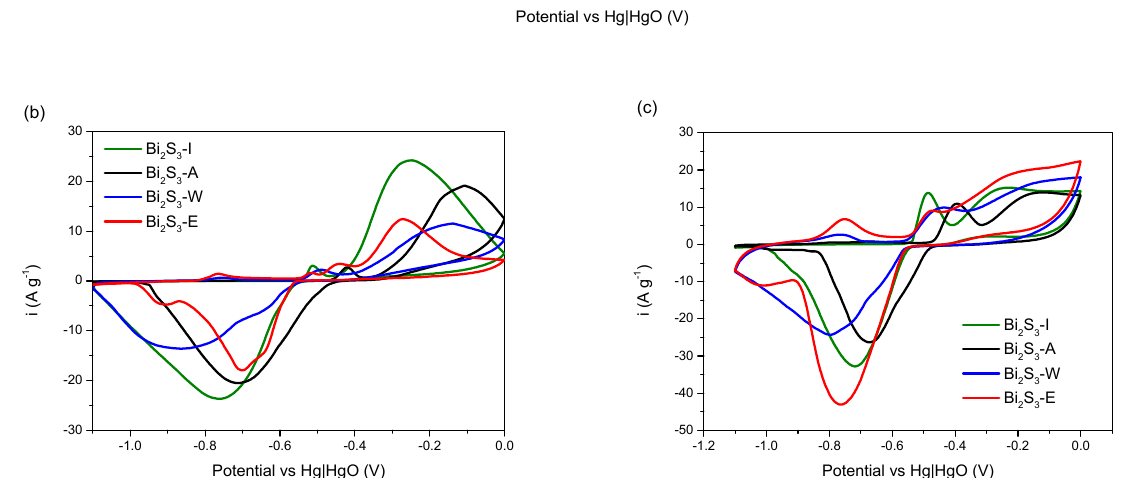
Figure 5. Cyclic voltammograms of the bismuth sulfides synthesized in different solvents at 1, 10, and 100 mV s − 1 ( a – c ).